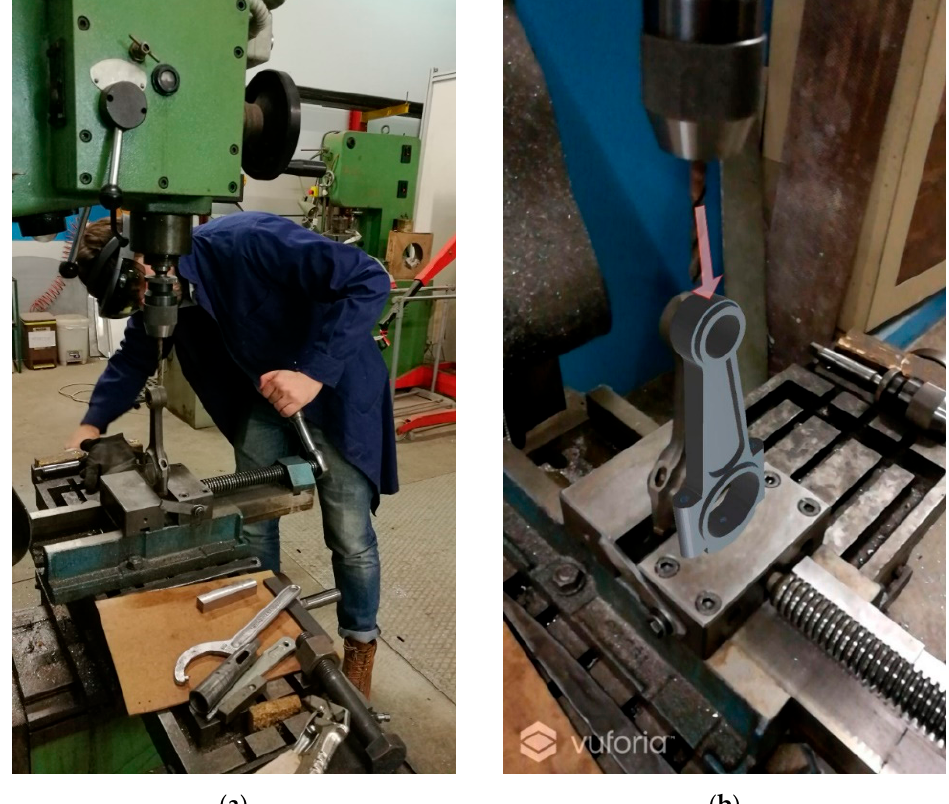
Figure 10. ( a ) Experiment carried out the University of Bologna workshop with AR technology by the authors to reproduce a factory environment. ( b ) 3D object positioned in real world.